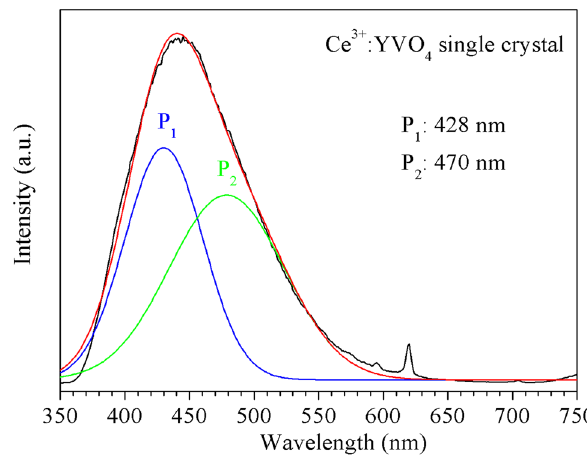
Figure 6: Gaussian fi tting curve of the emission spectra excited at 325 nm.